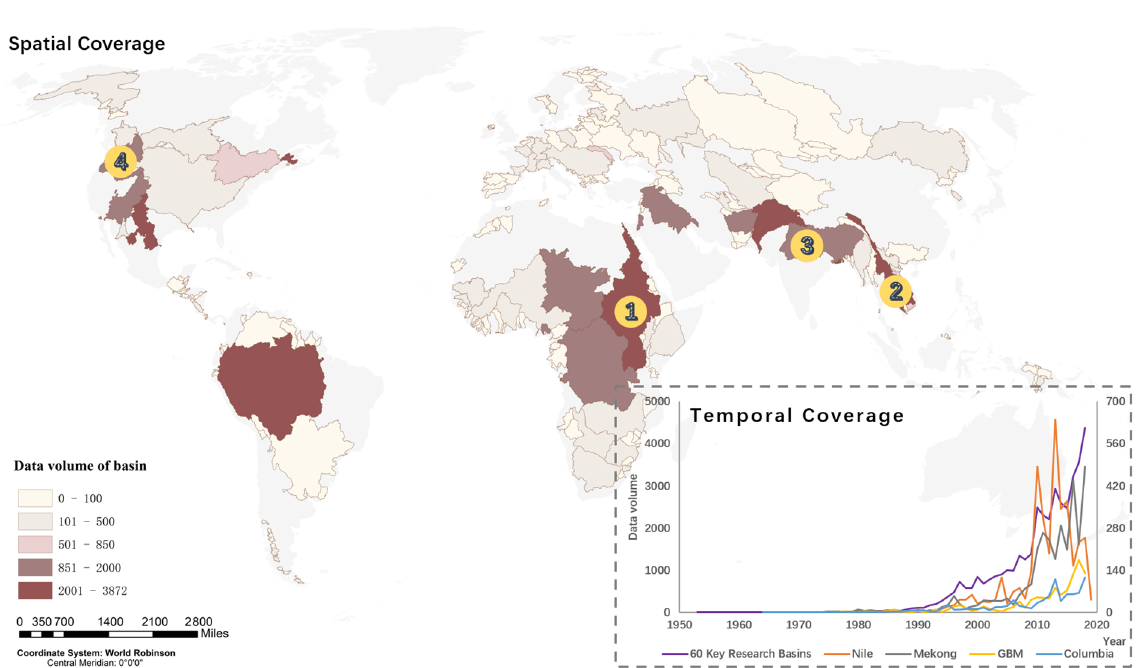
Figure 3. Spatial coverage and temporal coverage in the basin scale (1 – Nile; 2 – Mekong; 3 – GBM; 4 – Columbia).